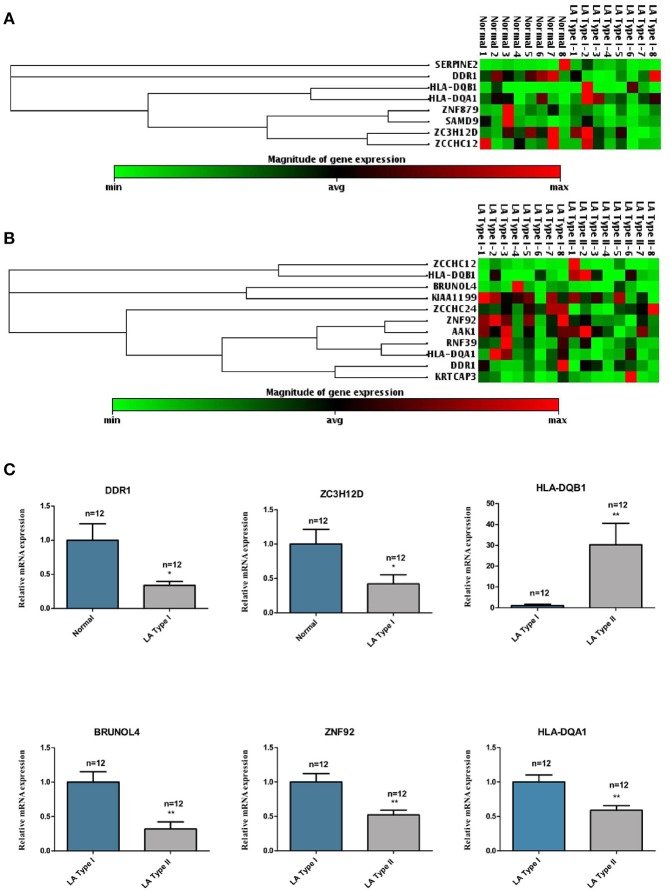
The mRNA expression levels of the LA occurrence and progression-associated genes in clinical LA samples. (A) represents the hierarchical clustering of 8 hyper/hypo-methylated genes associated with LA occurrence. (B) represents the hierarchical clustering of 11 hyper/hypo-methylated genes associated with LA progression. The green/red color represented a standardized level of mRNA expression of those genes in clinical samples. (C) shows the mRNA expression levels of 6 genes which were shown to be significantly up-regulated or down-regulated in LA occurrence (LA Type I vs. Normal) or progression (LA Type I vs. Normal) in additional 12 clinical LA samples. *P < 0.05, **P < 0.01, ***P < 0.001.